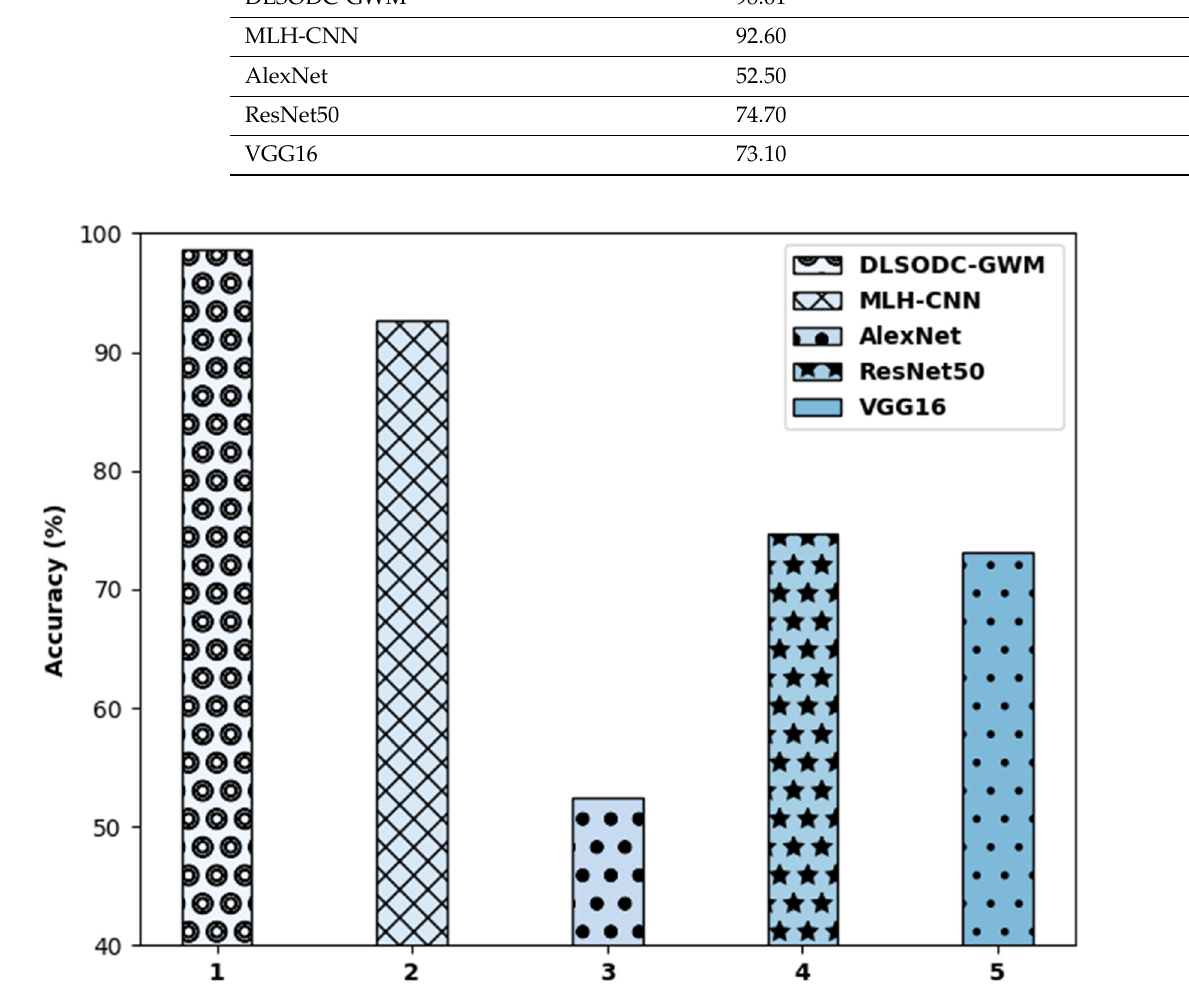
Figure 13. Accuracy analysis of DLSODC-GWM technique with recent algorithms.